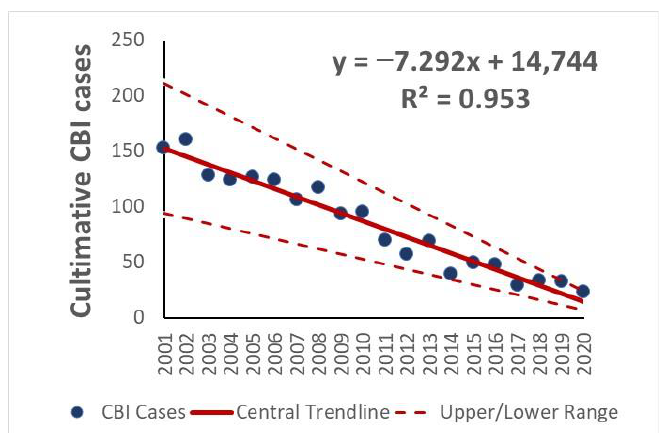
Figure 4. Annual variation in cumulative number of adults’ chronic bronchitis incidents due to PM 10 exposure. GΑΑ. Period 200 1 – 2020.